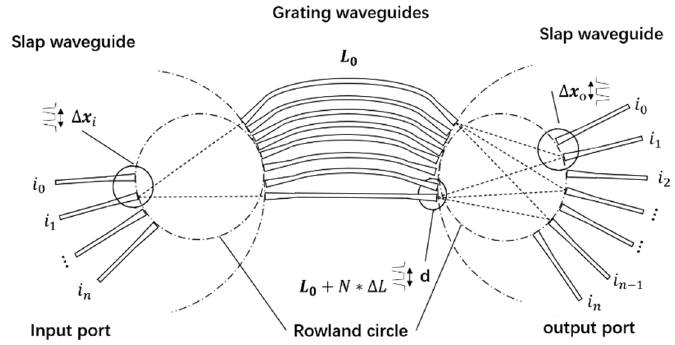
Figure 3. The structural diagram of